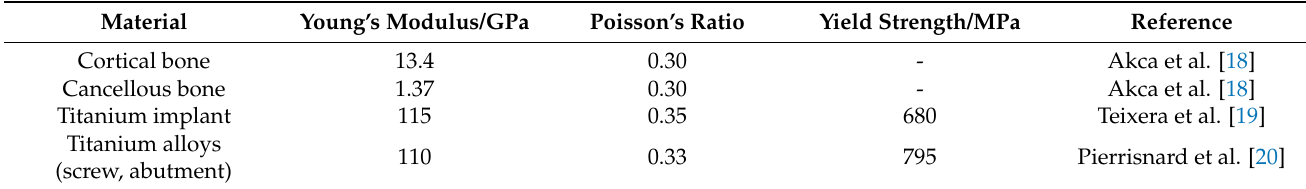
Table 2. Materials properties used in this study.